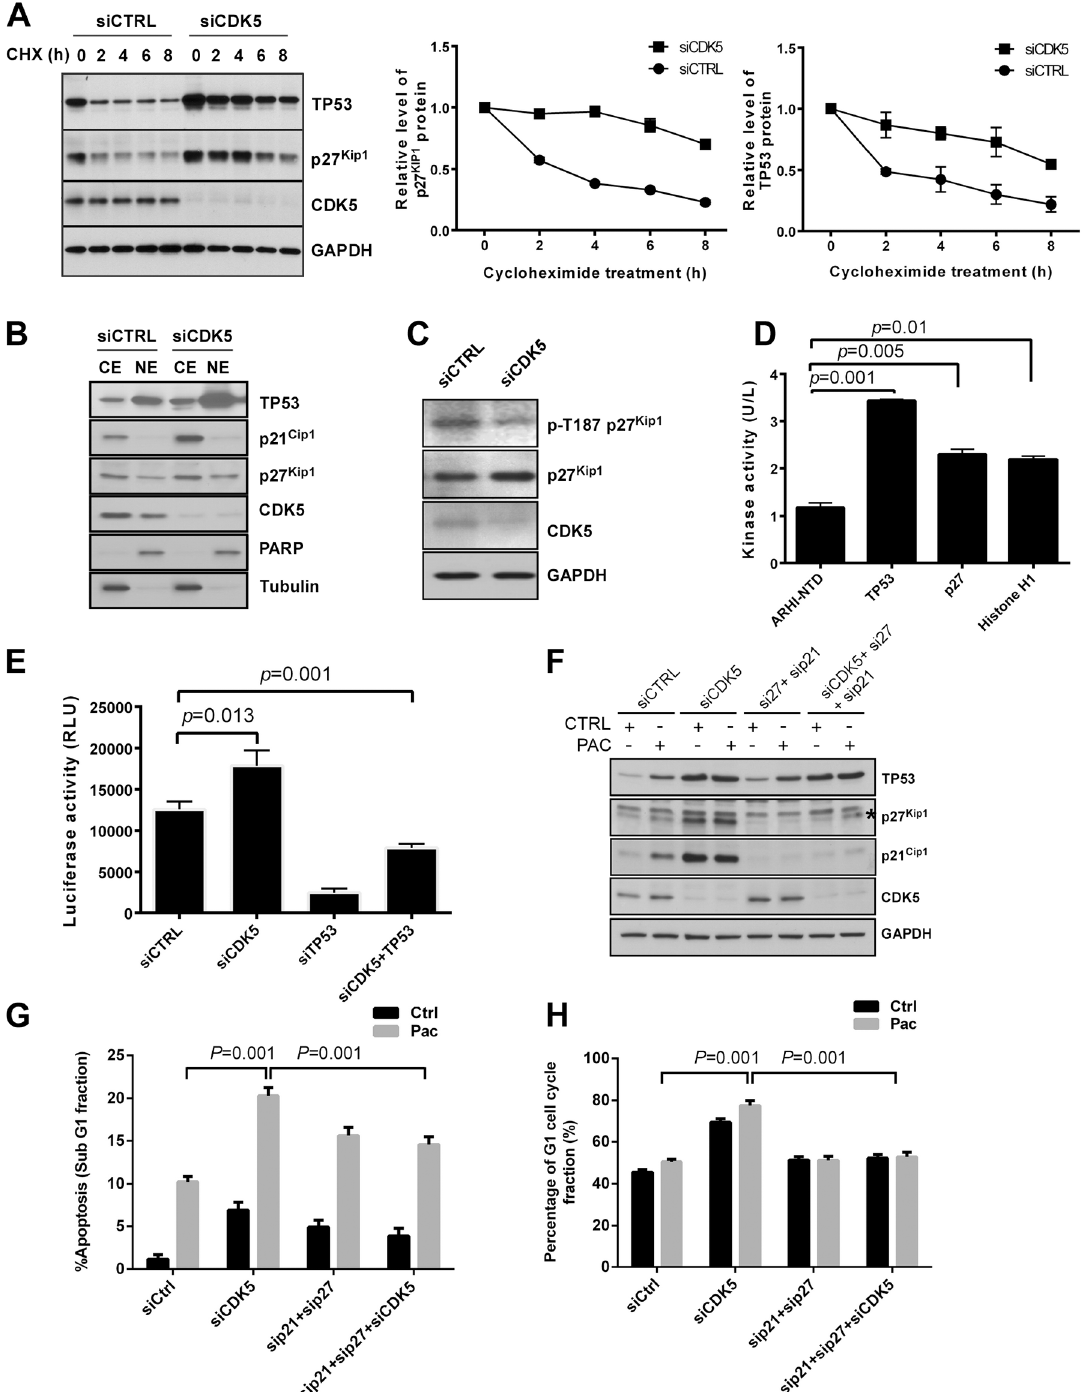
Fig 4. CDK5 knockdown increases TP53 and p27 Kip1 protein half-lives, increases nuclear localization of the two proteins, decreases p27 Kip1 p-T187 phosphorylation and induces p21 Cip1 in a TP53-dependent manner. ( A ) Transfection with CDK5 siRNA increased the half-life of p53 and p27 Kip1 protein. HEY cells were transfected with control siRNA or CDK5 siRNA for 24 h and then treated with 5 μ g/mL of cycloheximide (CHX) for the indicated intervals. Cell lysates was subjected to Western analysis with the antibodies indicated. ( B ) CDK5 siRNA increased the nuclear localization of p53 and p27 Kip1 . HEY cells were transfected with Control siRNA or CDK5 siRNA for 24 h and subjected to fractionation into cytoplasmic and nuclear components. Cytoplasmic (CE) and nuclear (NE) extracts were analyzed by immunoblotting. ( C ) CDK5 siRNA decreased the phosphorylation of p27Kip1 at T187. The cell Immunoblot analysis was performed with antibodies against phosphorylated and total p27Kip1. ( D ) CDK5 enhanced phosphorylation of TP53 and p27 Kip . A